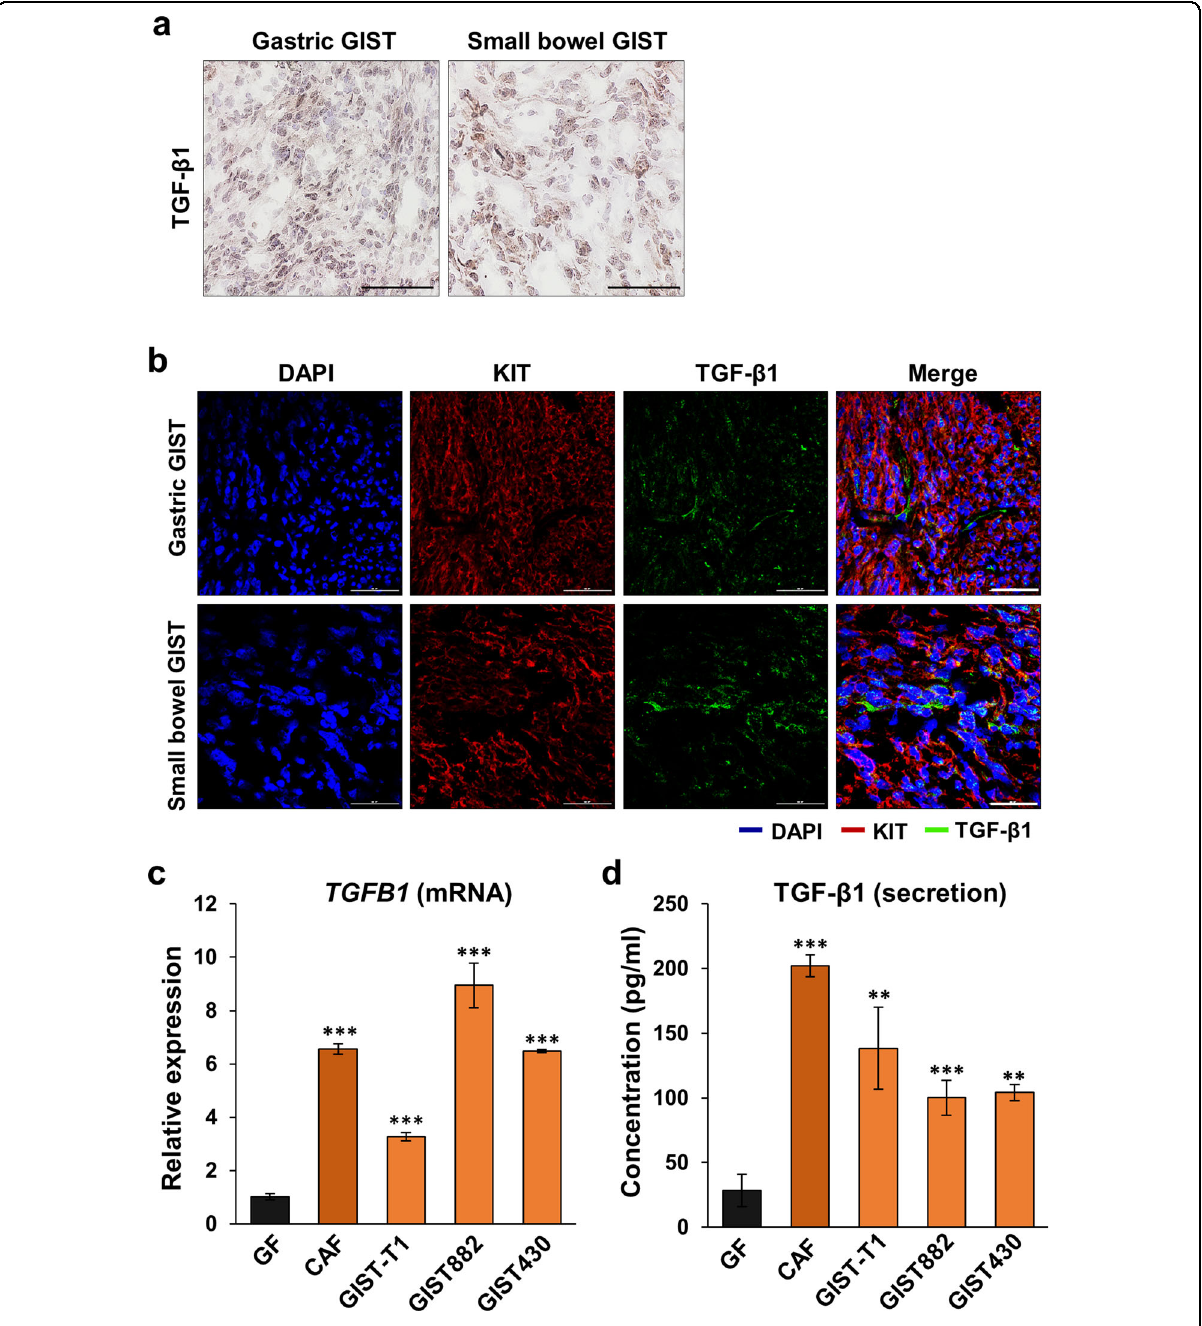
Fig. 3 TGF- β 1 is highly expressed in GIST cells and CAFs. a Representative immunohistochemistry (IHC) images with staining for TGF- β 1 in the frozen tumor sections collected from human GISTs harboring mutant KIT . Scale bars, 100 µm. b Representative immuno fl uorescence (IF) images of TGF- β 1 (green), KIT (GIST marker; red), and DAPI (nuclei; blue) staining in the resected sections. Scale bars, 50 µm. c mRNA expression of TGFB1 in GFs, GIST-T1, GIST882, GIST430, and CAFs by qPCR. d Comparison of TGF- β 1 levels measured by enzyme-linked immunosorbent assay (ELISA) in GFs, GIST- T1, GIST882, GIST430, and CAFs. After each cell line was seeded for 48 h in the absence of FBS, the supernatant was collected to perform ELISA. All graphs show mean ± SEM, and p values were represented by ANOVA analysis. ** p < 0.01, *** p <